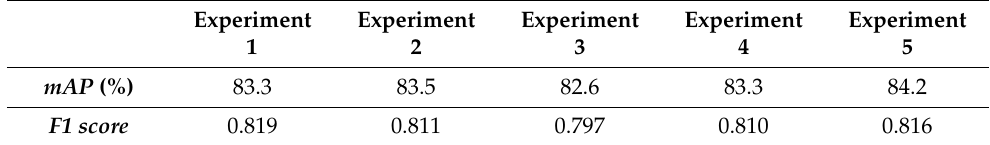
Table 10. Results of YOLOv5-TDHSA on TT100K dataset.